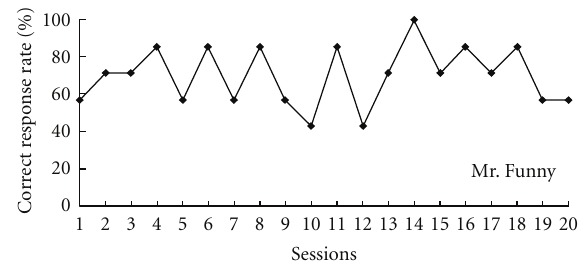
Figure 7: Correct response rates over sessions for simultaneous vis- ibility. The correct response rates were calculated as the percentage of “attempt made” trials when the remainder was 2 and 1, and “attempt not made” trials when the remainder was 0, over the total 7 trials for each session.